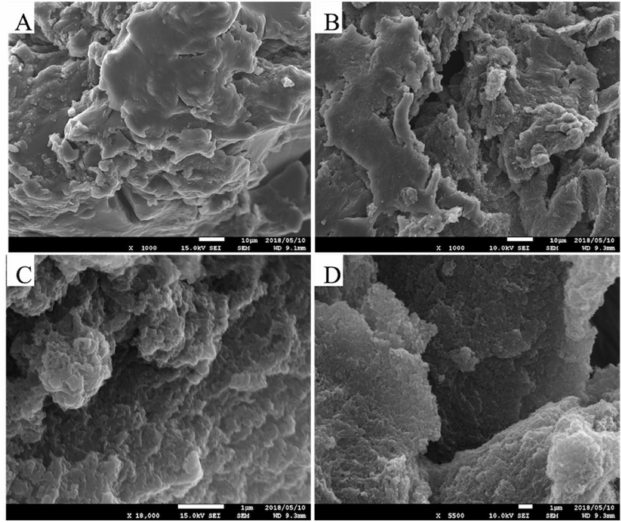
Figure 6. FE-SEM images of ( A , B ) α -CD/ODA-PHA and ( C , D ) ODA-PHA.